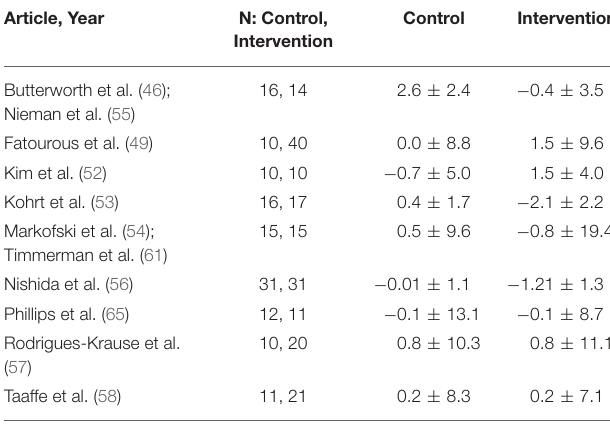
TABLE 1 | Weight (kg) change